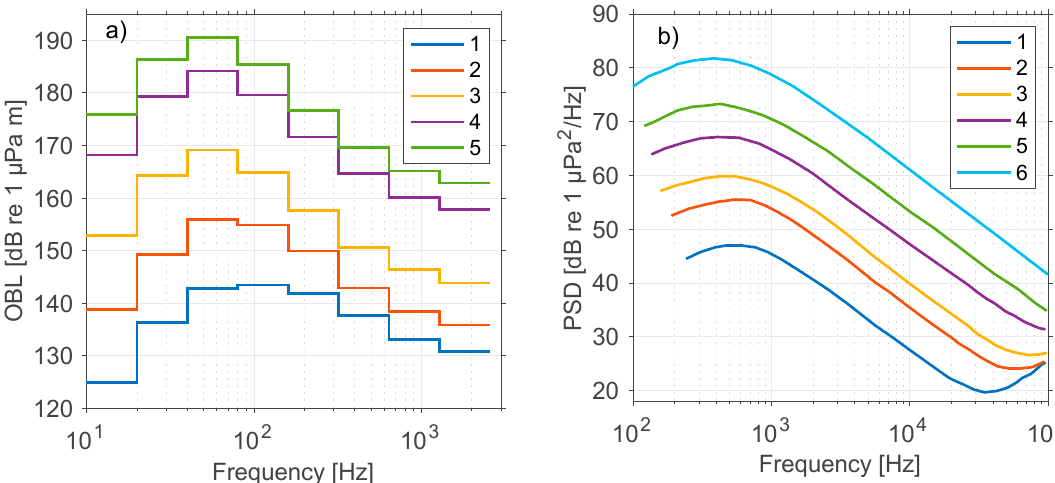
Figure 1. ( a ) Underwater ship noise source levels as full-octave band levels (OBL) for ships of lengths <25 m (Class 1), ≥ 25–<50 m (Class 2), ≥ 50–<100 m (Class 3), ≥ 100–<200 m (Class 4), and ≥ 200 m (Class 5); ( b ) Power spectral density levels (PSD) of wind noise under water at wind speeds 1–3 kn (Beaufort 1; curve 1), 4–6 kn (Beaufort 2; curve 2), 7–10 kn (Beaufort 3; curve 3), 11–21 kn (Beaufort 4–5; curve 4), 22–47 kn (Beaufort 6–9; curve 5), and ≥ 48 kn ( ≥ Beaufort 10; curve 6).